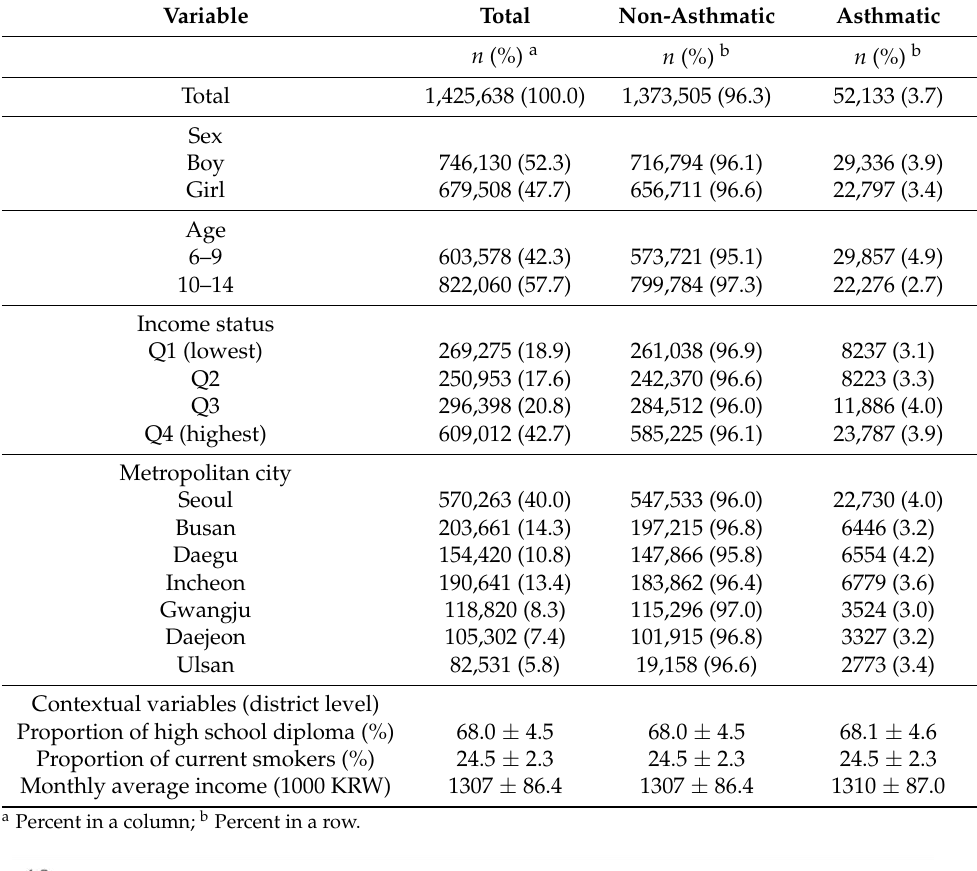
Table 1. Descriptive statistics of the study participants at the baseline.